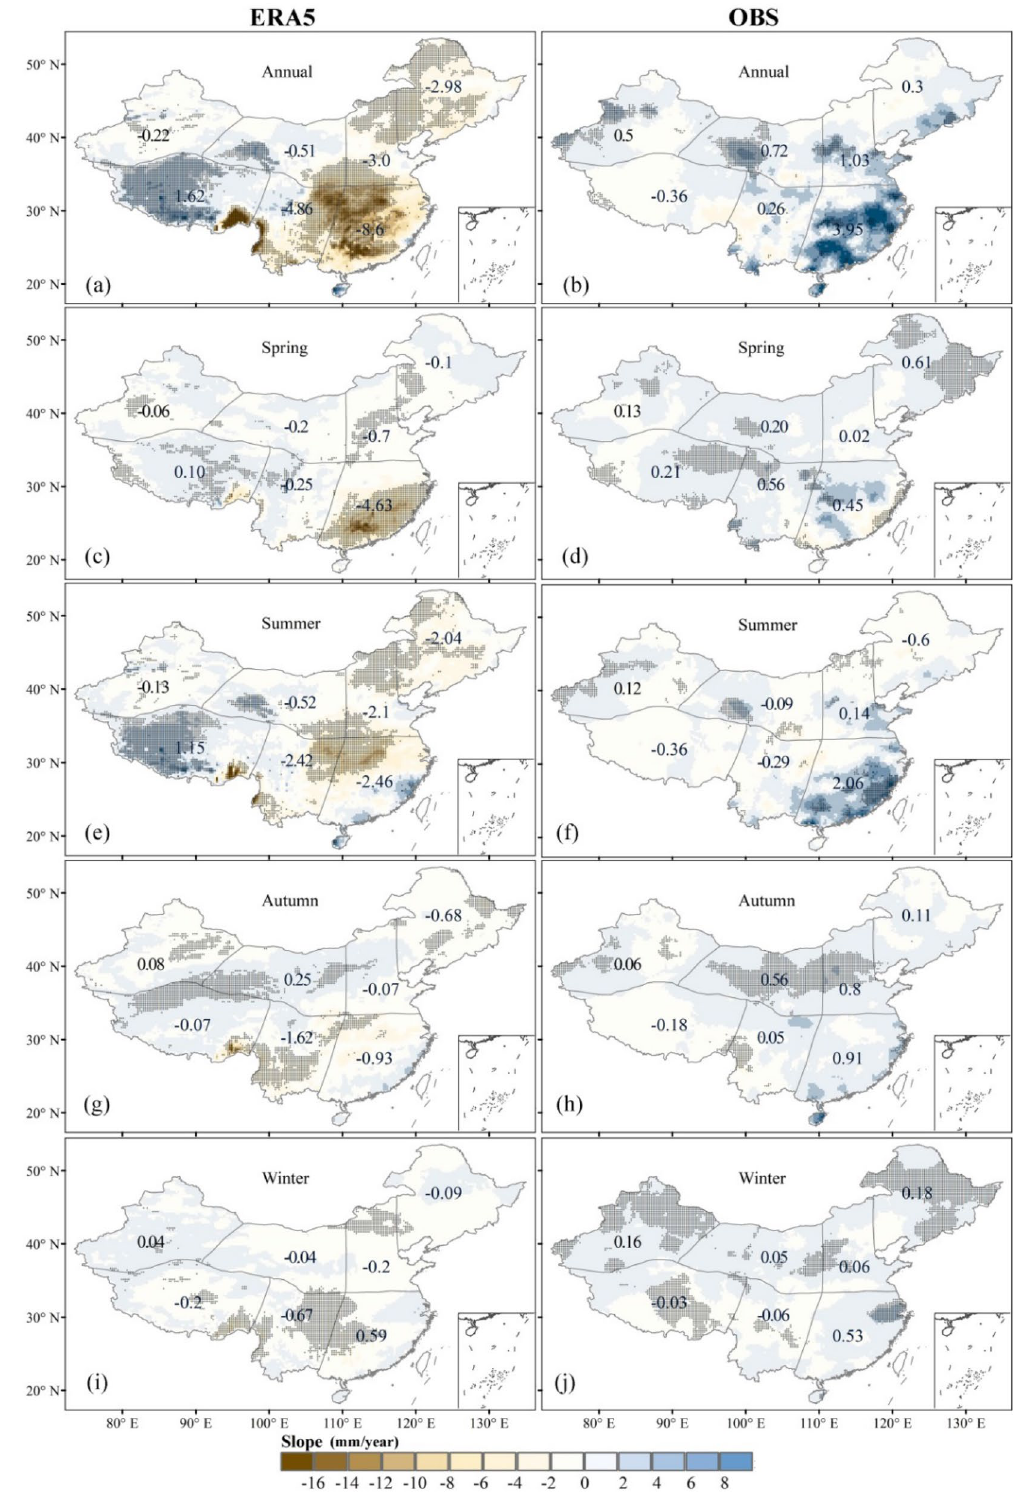
Figure 6. Spatial patterns in annual and seasonal slope variations (1979–2018 average) in Chinese mainland. The number is the average slope of each division. Note: The black points indicate trends significant at 95% confidence level by Mann–Kendall test (ArcGIS Desktop. 10.0. ESRI, California, US. https:// deskt op. arcgis. com/ zh-